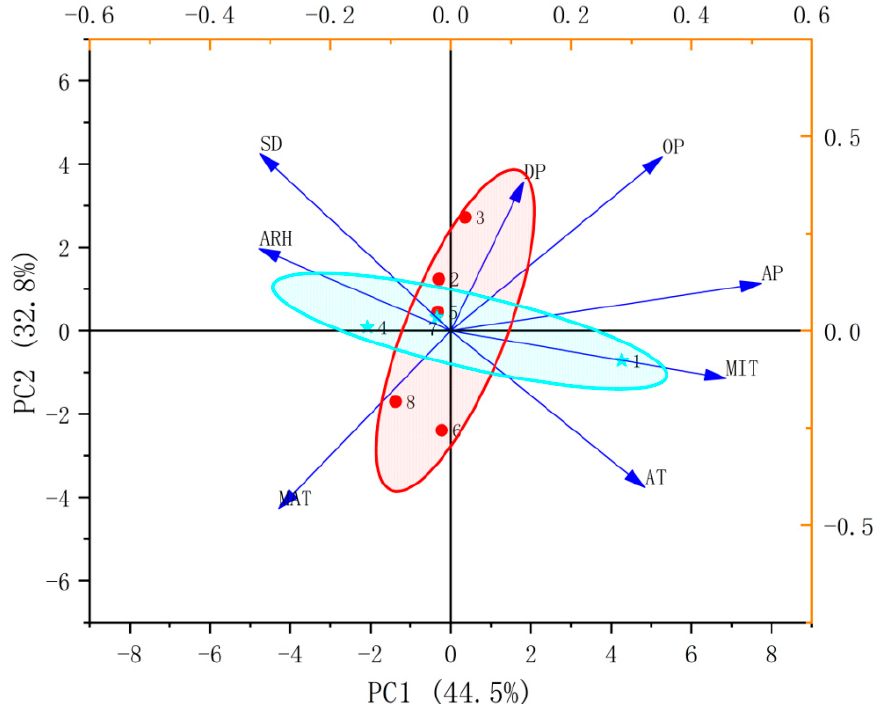
Figure 9. PCA score plots using flavonoid types with different climate factors ( n = 3). 1–8: isotrifolin, rutin, myricetin deoxyhexoside, quercetin-3-rutinoside, luteolin 6-C-glucoside, quercitrin, genestein G2, luteolin-4 ′ - O -(6 ″ -trans-caffeoyl)- β - D -glucopyranoside. The blue arrows refer to different climate factors.